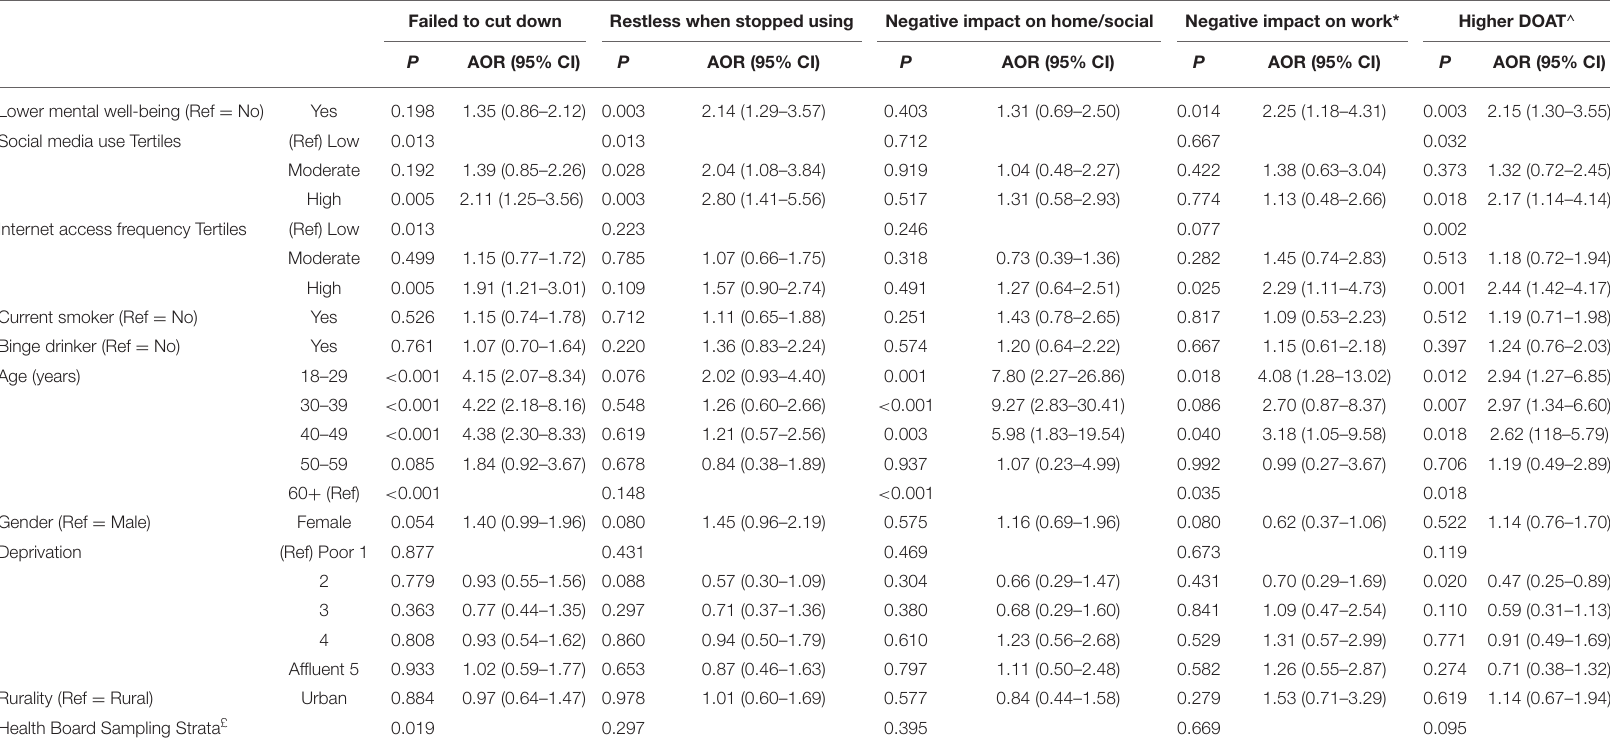
TABLE 3 | Logistic regression analysis of factors associated with having a high Digital Overuse and Addiction Traits (DOAT) score. Failed to cut down Restless when stopped using Negative impact on home/social Negative impact on work* Higher DOAT